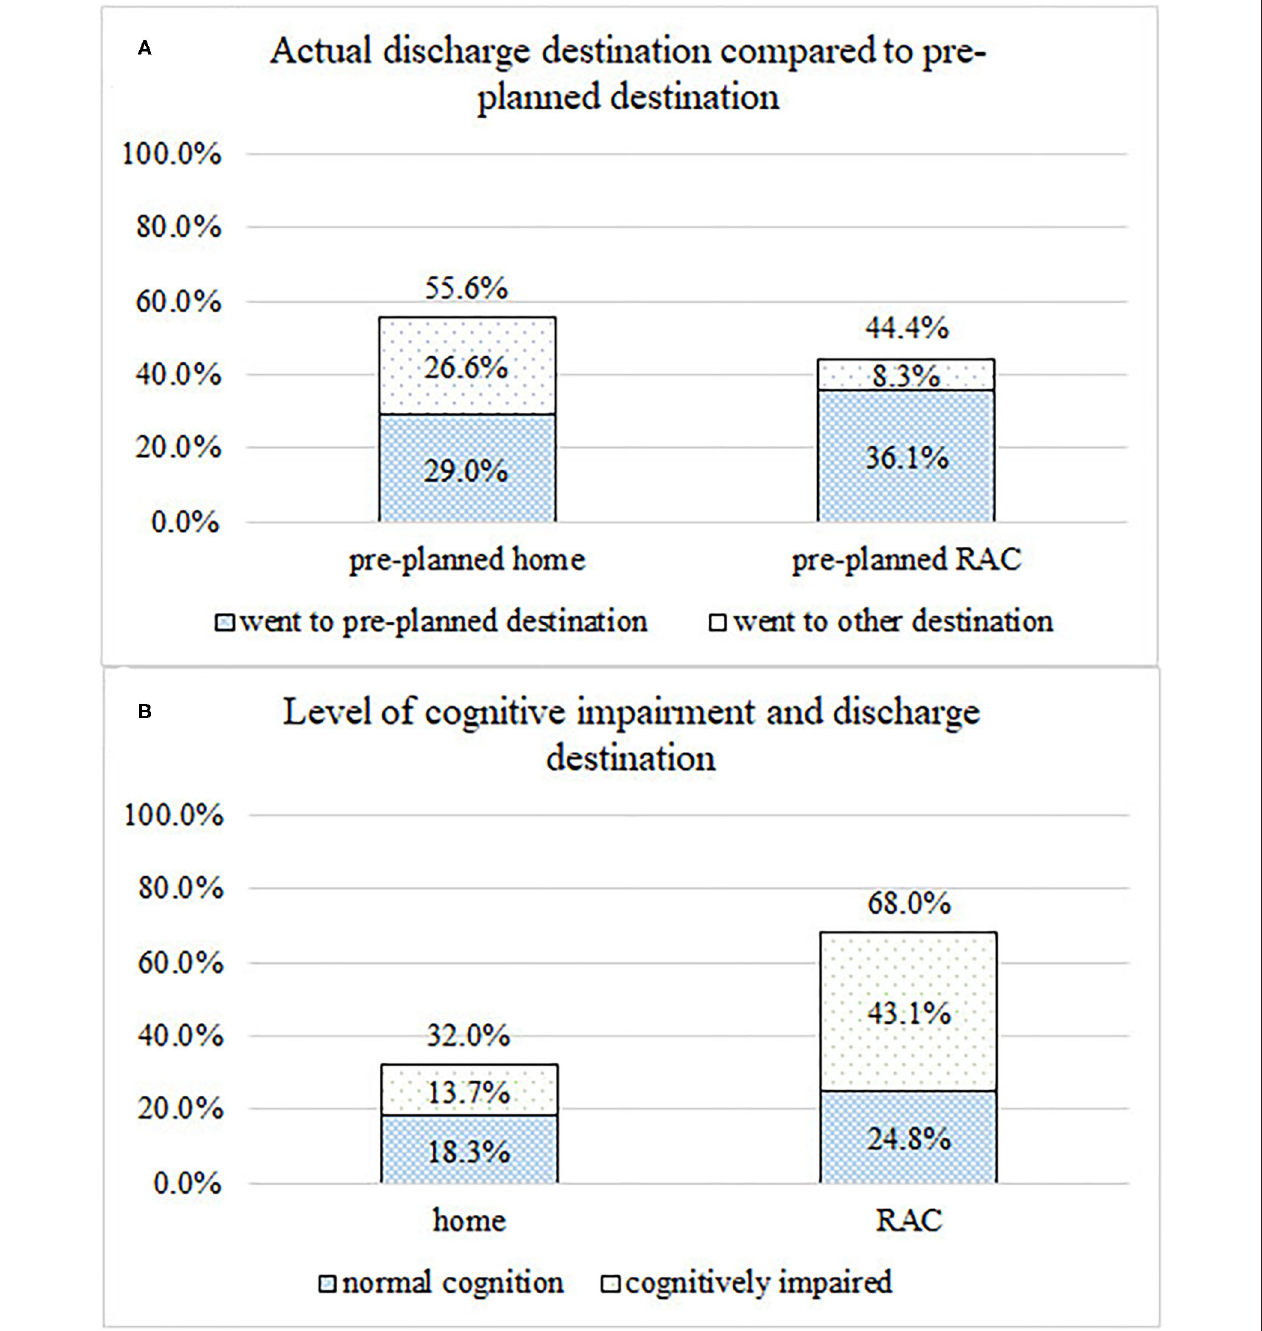
FIGURE 1 | (A) Proportion of cases actual discharge destination compared to pre-planned discharge destination. (B) Number of cases discharged home compared to other discharge destinations, categorized by presence or absence of cognitive impairment.